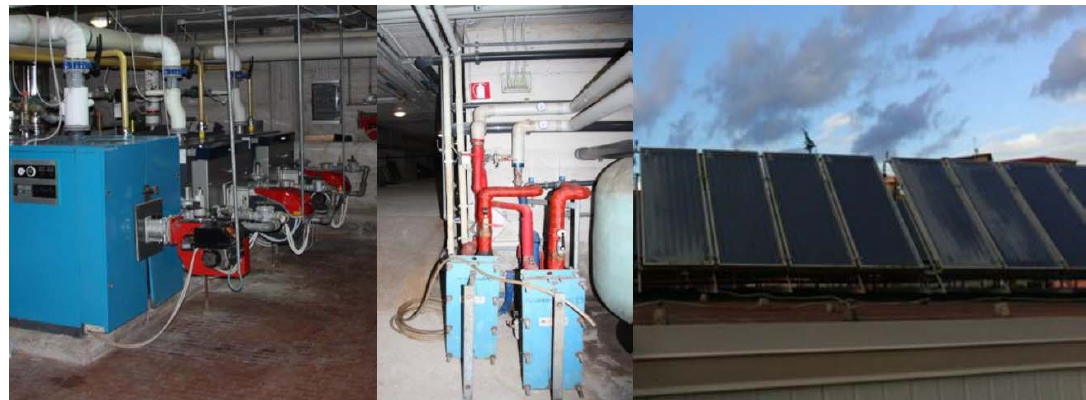
Figure 3. Main components of the swimming pool existing installation: natural gas boilers ( left ), swimming pool heat exchangers ( centre ), thermal solar collectors ( right ).